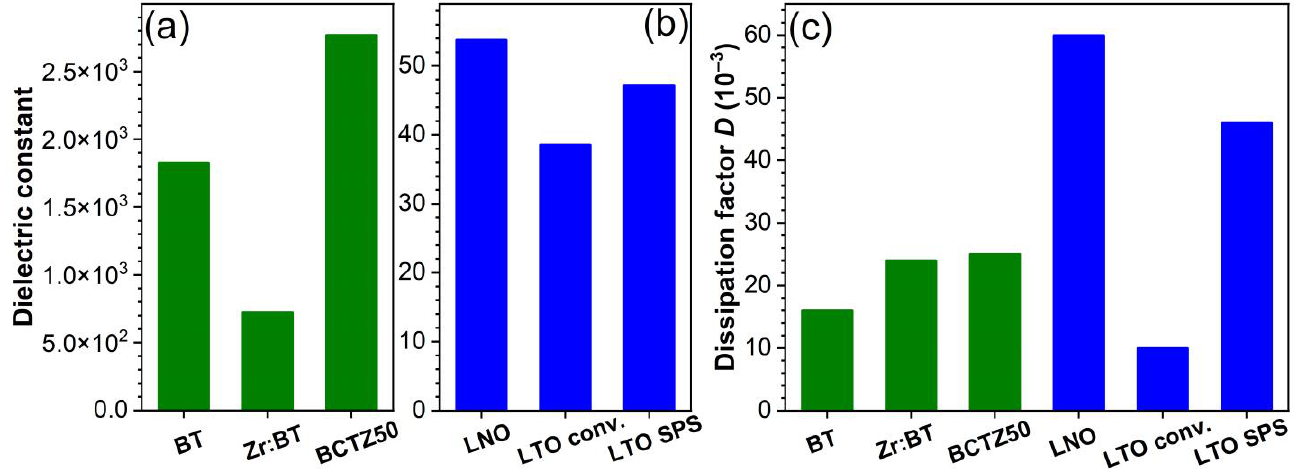
Figure 4. ( a , b ) Dielectric constant of the: ( a ) BT, Zr:BT, BCTZ50 and ( b ) LNO and LTO sintered ceramics. ( c ) Dielectric losses (dissipation factors) of the BT, Zr:BT, BCTZ50, LNO and LTO ceramics. The hysteresis loops acquired for the BT, Zr:BT and BCZT50 samples are shown in Figure 5a. Similar polarization–electrical (P–E) field characteristics were recorded for the BT and BCTZ50 samples, eliciting sharp loops with an S-shape and small coercive fields (below 3 kV/cm), unlike the loops of the Zr:BT ceramics, which were significantly wider and had higher coercive fields (6 kV/cm). BT yielded the highest polarization (P max = 25 µC/cm 2 ). The remnant component of the polarization (P R ), which is due to electric dipoles